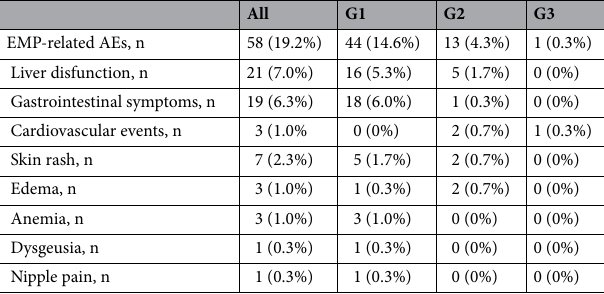
Table 4. EMP related adverse events (Neoadjuvant EMP, n =